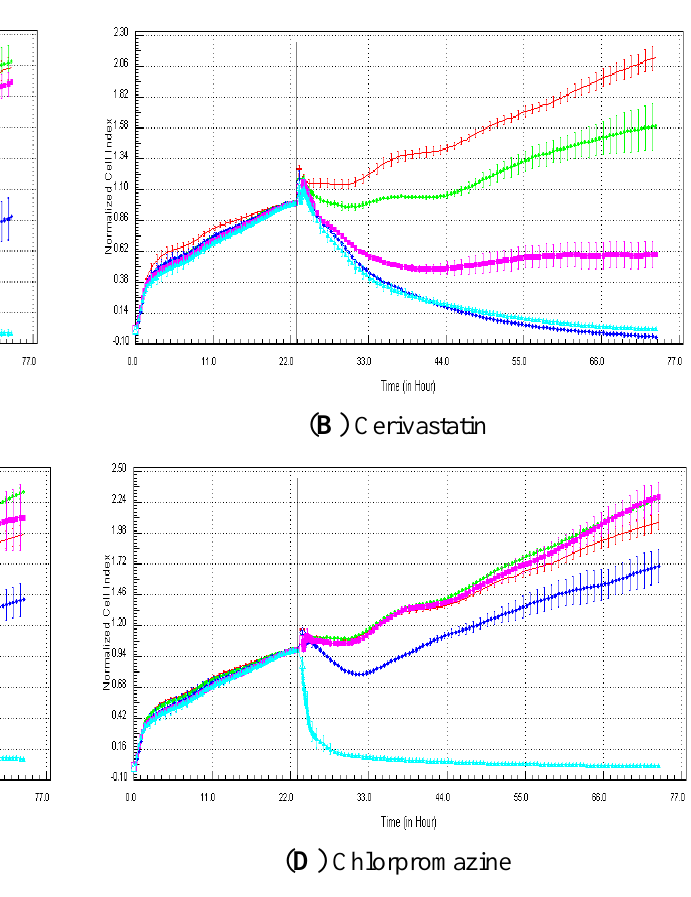
Figure 1. Examples of real-time cell analyzer (RTCA) profiles generated with hepatotoxic compounds in HepG2 cells. HepG2 cells were exposed to: 0 (0.5% dimethyl sulfoxide (DMSO), red curve), 0.1 (green curve), 1 (purple curve), 10 (dark blue curve) and 100 (light blue curve) µM with six different compounds. The drugs tested were astemizole ( A ), cerivastatin ( B ), amiodarone ( C ), chlorpromazine ( D ), aflatoxin B1 ( E ) and tacrine ( F ). Cell indexes were normalized with the last time point before compound addition. The normalized time point is indicated by the vertical line. Each data point was calculated from triplicate values (except for control cells n = 6). Data represent the average ± standard deviation. For more details, please refer to the Materials and Methods